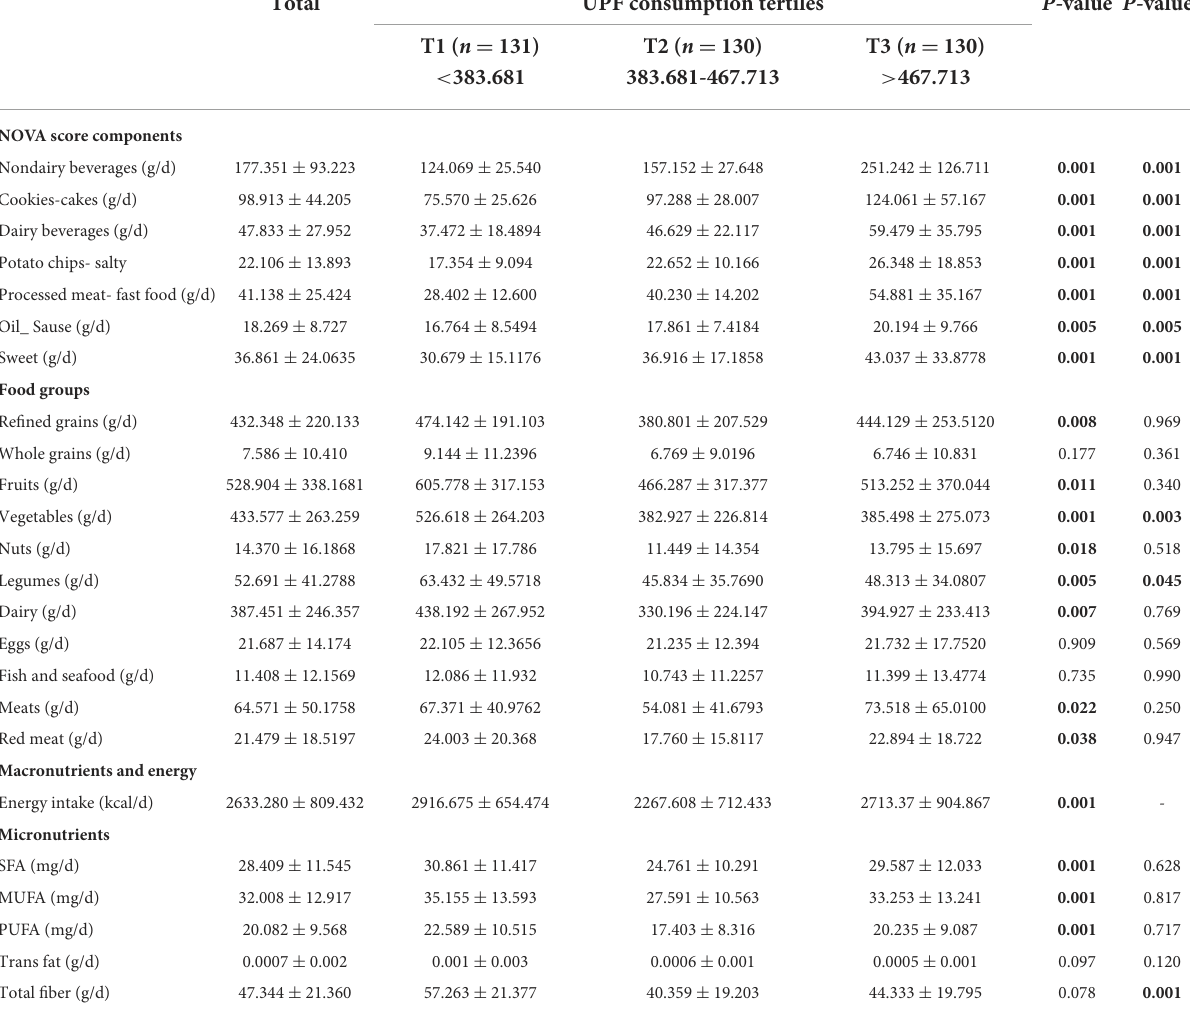
TABLE 2 Dietary intakes among tertiles of the NOVA score in obese and overweight women ( n Total UPF consumption